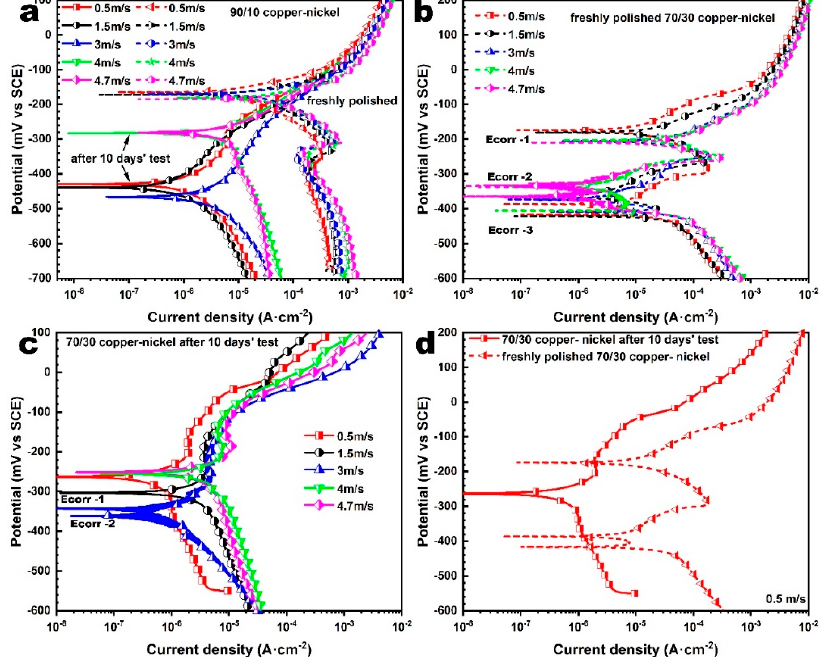
Figure 5. Potentiodynamic polarization curves of 90/10 and 70/30 samples tested in 1 wt% NaCl solution at different flow velocities: ( a ) for the freshly polished 90/10 samples as well as the samples after the 10-day erosion–corrosion test at different flow velocities; ( b ) for the freshly polished 70/30 samples; ( c ) for the 70/30 samples after the 10-day erosion–corrosion test at different flow velocities; and ( d ) a comparison of the polarization curve of the 70/30 sample after the 10-day erosion–corrosion test at 0.5 m/s with that of the freshly polished 70/30 sample.